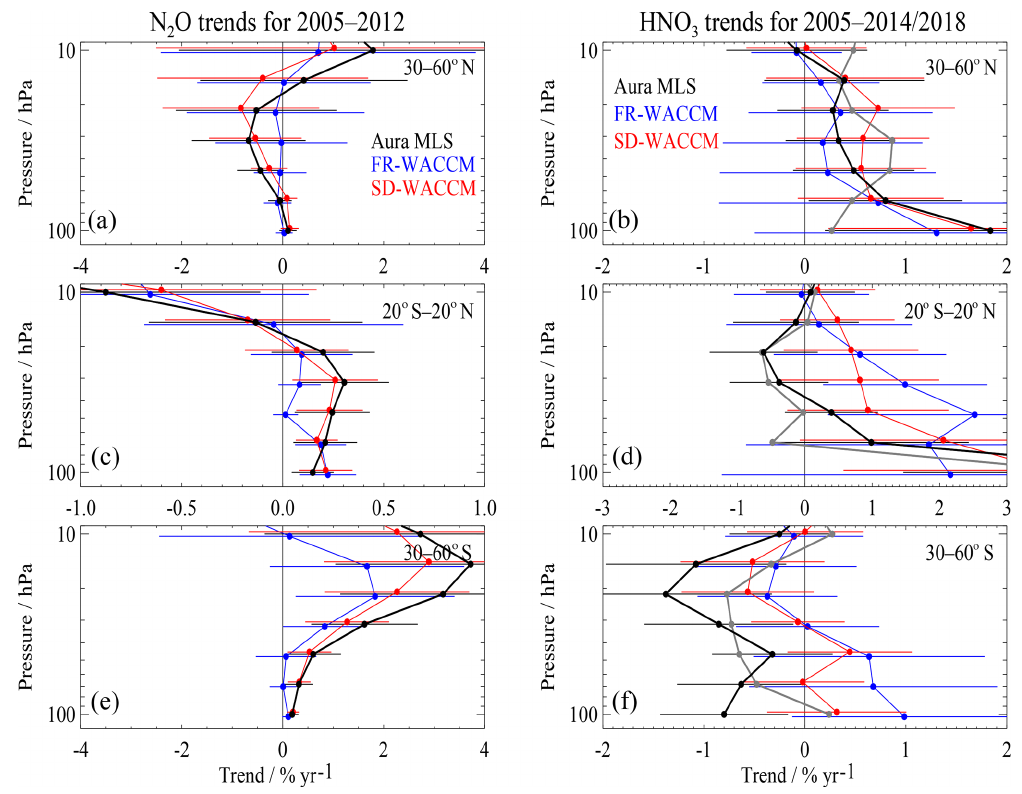
Figure 25. Same as Fig. 23 but for N 2 O (a, c, e) and HNO 3 (b, d, f) data and model trends in the lower stratosphere. The N 2 O data results are from the N 2 O–640 MLS product (retrieved from the 640GHz radiometer band data), which was discontinued in 2013 because of an instrument issue affecting this band (see text), and these data and model trends apply to the 2005–2012 period. The HNO 3 trend results (data and models) are for 2005–2014, with additional data results (in grey) for